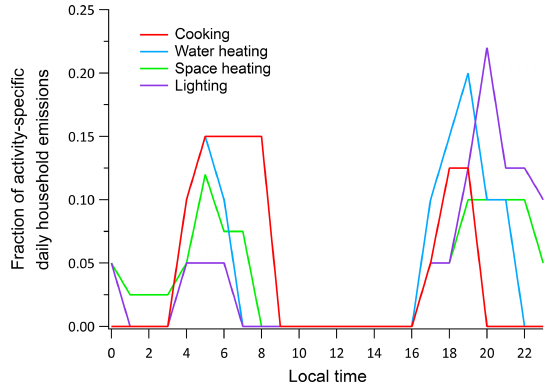
Figure 2. Fraction of daily household emissions by quantifiable fuel-use activity. Red, green, blue, and purple indicate cooking, space heating, water heating, and lighting, respectively. This rep- resents the fraction of activity-specific daily emissions at each hour. Each species obeys the same profile. While profiles for heating are shown, the inventory assumes temperatures too high for this activity to take effect.